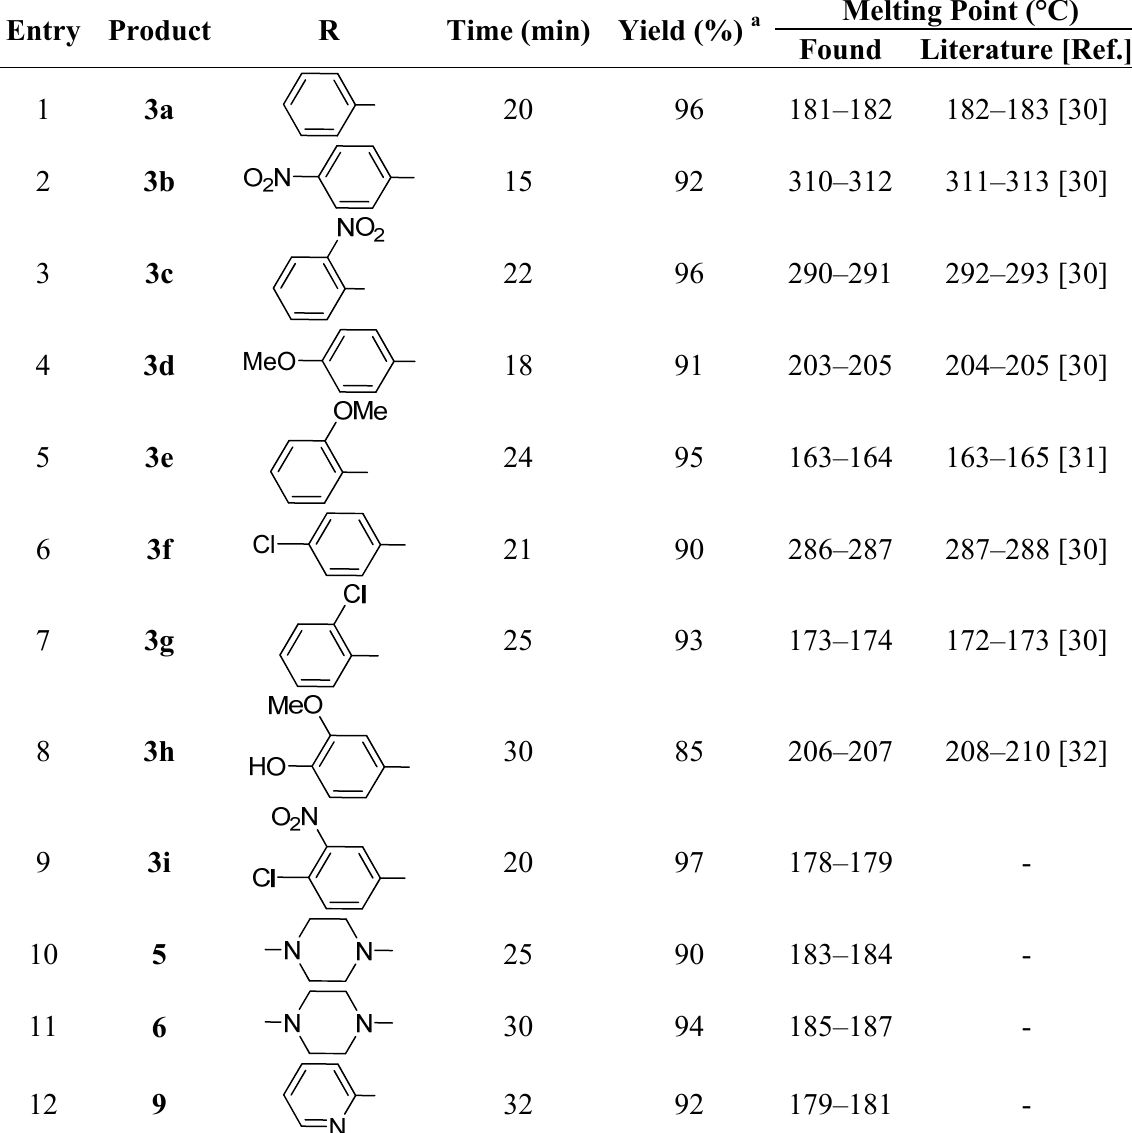
Table 1. Synthesis of xanthenes catalyzed by PEG-OSO aldehydes and cyclic 1,3-dicarbonyl